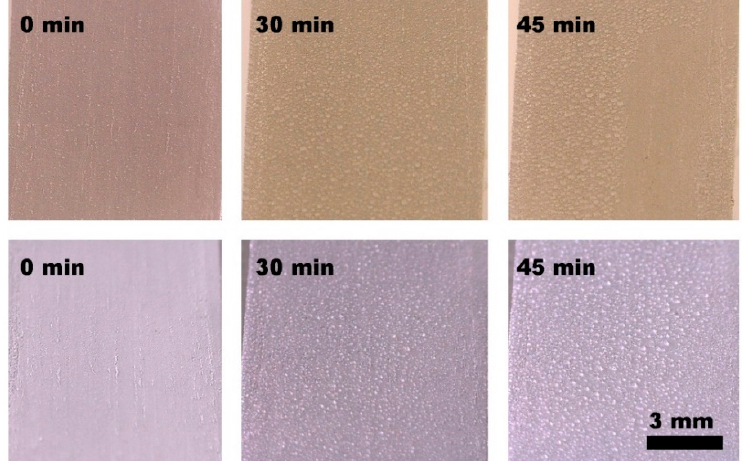
Figure 15. Condensation of water droplets on to superhydrophobic coating. The top images correspond to a tilt of 90 ◦ while the bottom images are from the sample tilt 45 ◦ . All the images have the same